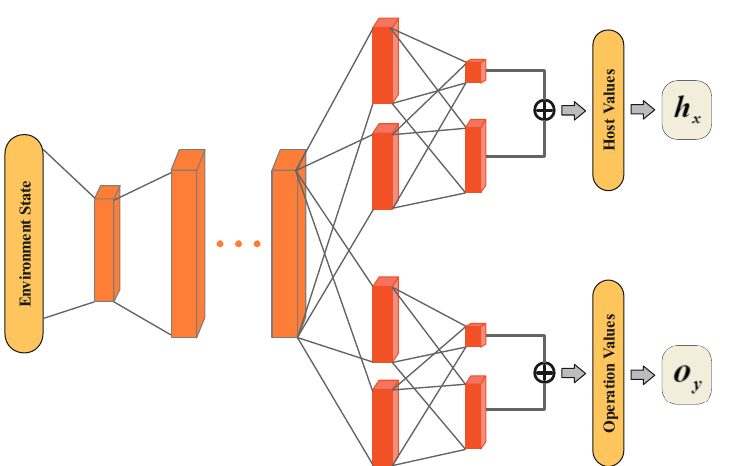
Figure 2. Schematic illustration of the decoupling NDSPI-DQN. Two streams share the hidden layers and each of them outputs its Q value using the dueling network architecture with the noisy linear